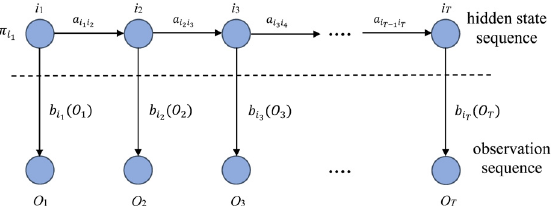
Figure 9. The process of HMM transition state